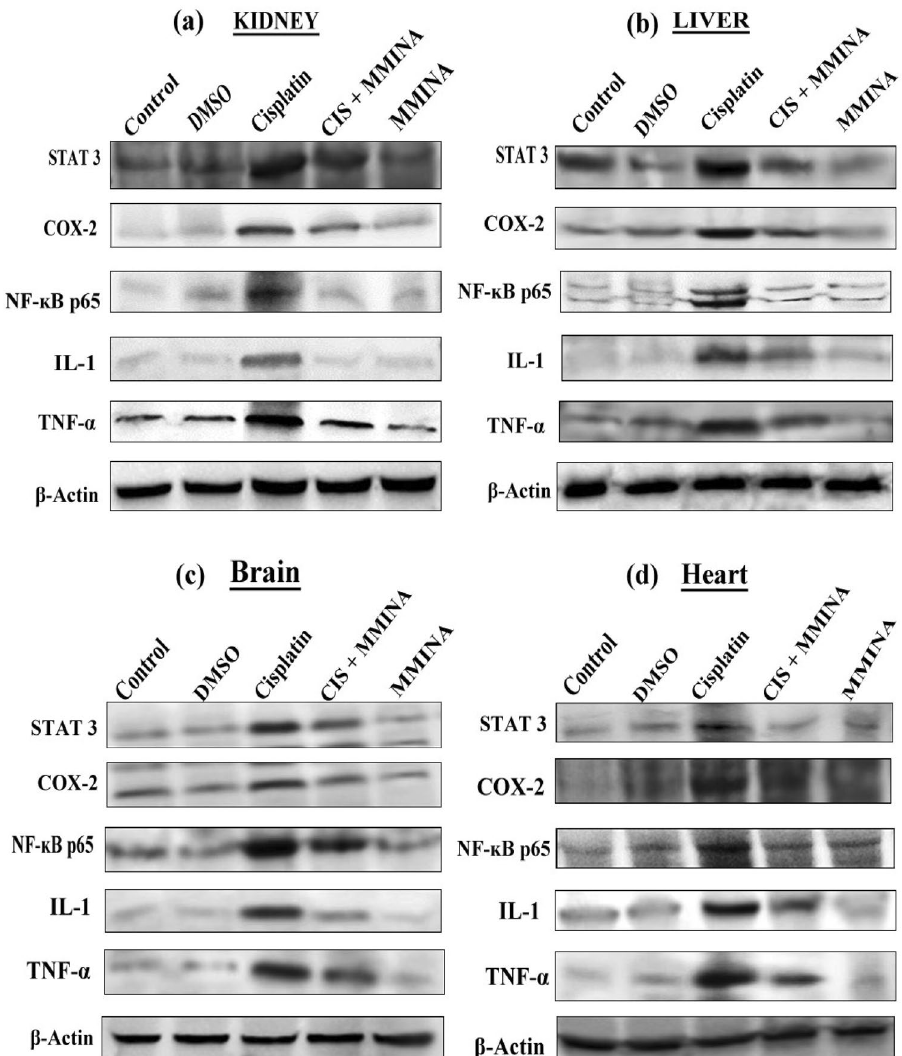
Figure 5. Western blot analysis of STAT3, COX2, NFĸB p65, IL1 and TNF-α protein expression in ( a ) Kidney, ( b ) Liver, ( c ) Brain and ( d ) Heart tissue lysates from different treatment groups. Treatments are indicated above the blots. Full sized blots are included in the Supplementary file S3. All gels and blots were run under the same experimental conditions as described in